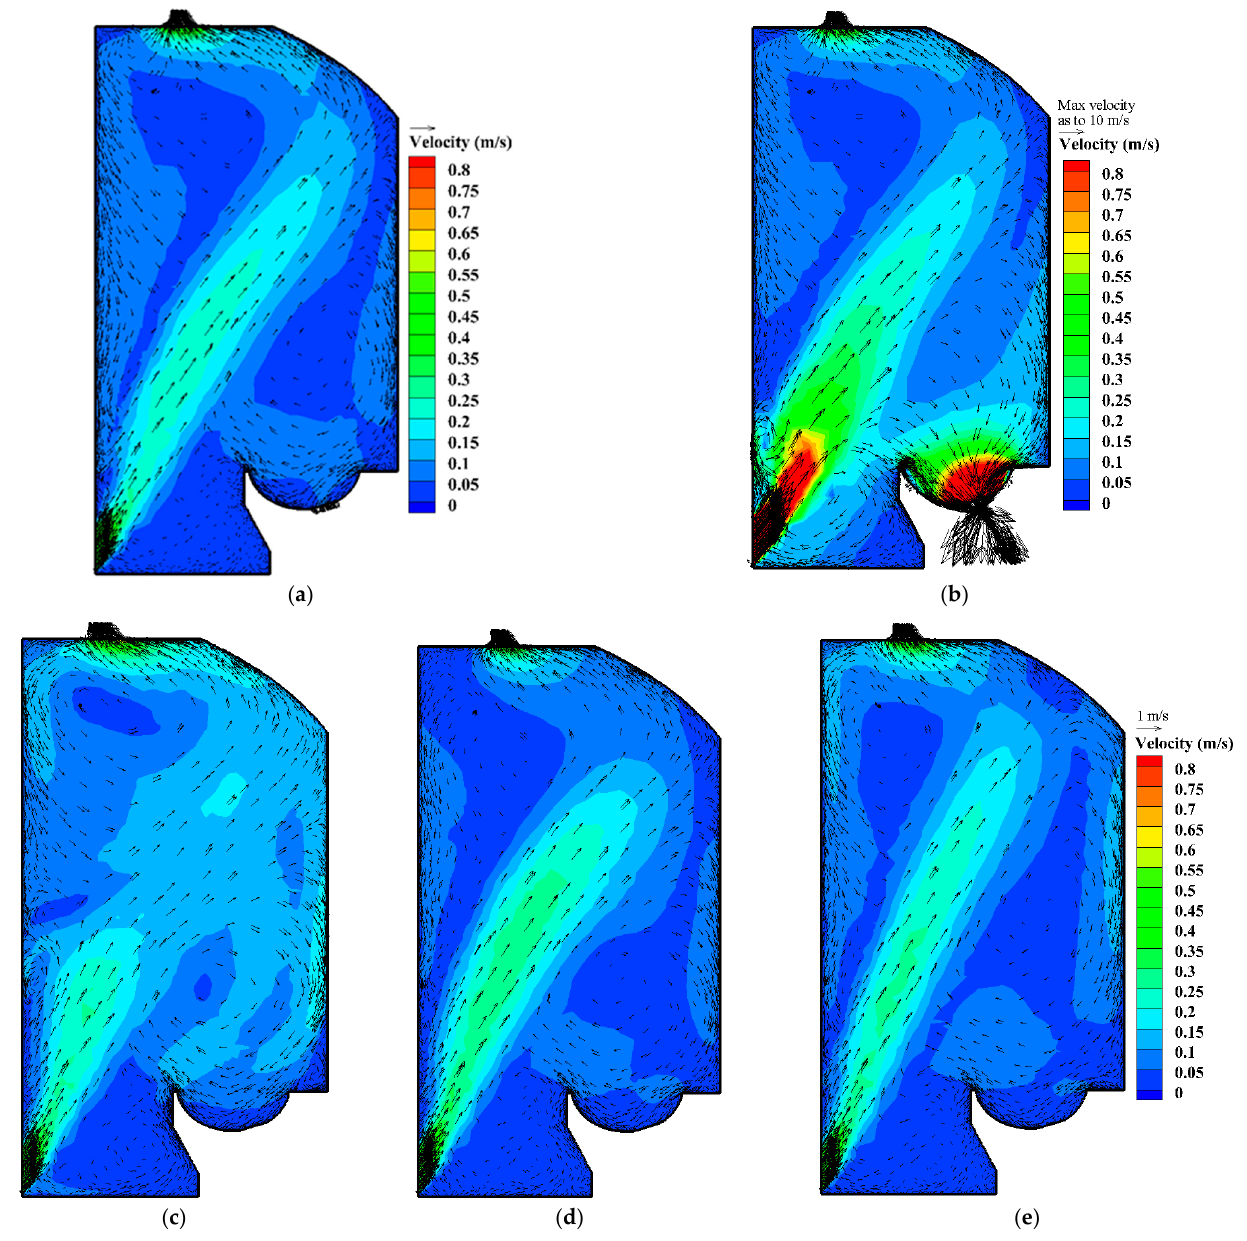
Figure 6. Velocity field at the symmetrical plane of the toilet for Case 1 after flushing ( t = 0 when toilet flush starts) at ( a ) steady state; ( b ) 2 s; ( c ) 10 s; ( d ) 25 s; ( e ) 65 s.